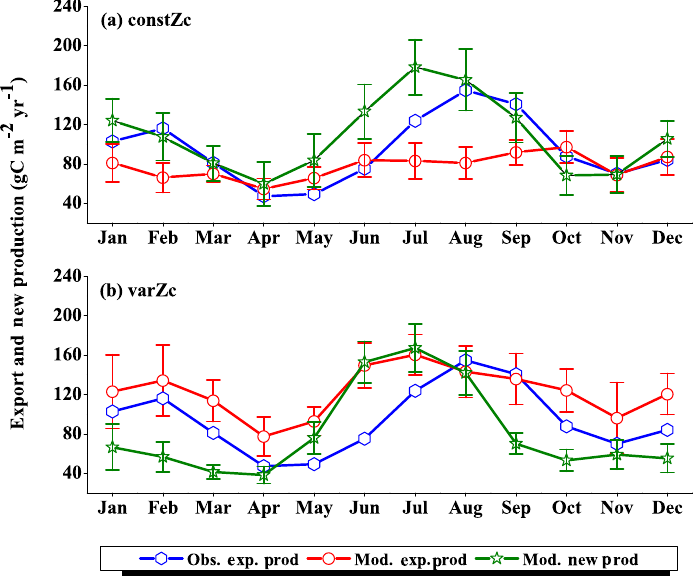
Figure 7. Comparison of model export production (Mod. exp. prod) and new production (Mod. new prod) with satellite-derived export production (Obs. exp. prod) for (a) const Zc and (b) var Zc simulations for WAS. Units are gCm − 2 yr − 1 . Legends are common for both